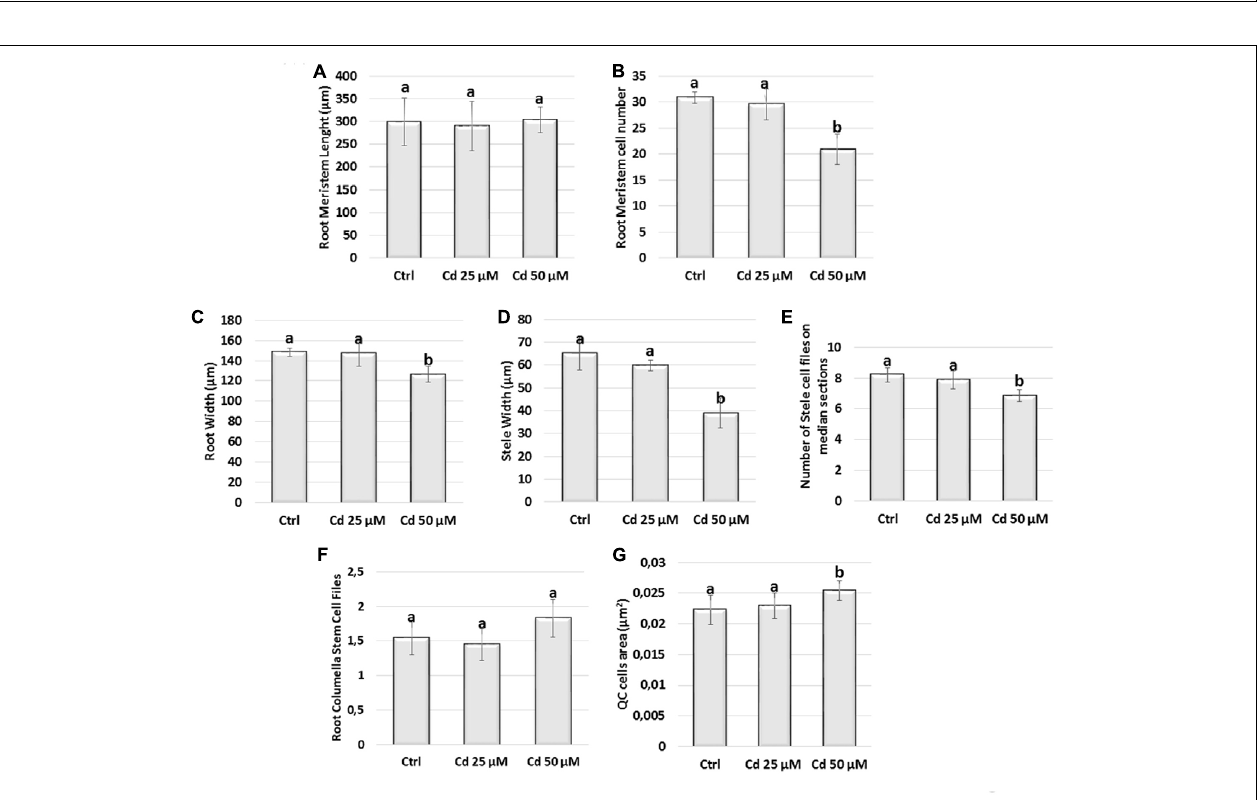
FIGURE 2 | (A) Meristem length ( µ m), (B) meristem cell number, (C) meristem width ( µ m), (D) stele width ( µ m), (E) stele cell files number, (F) calyptrogen layers number, (G) quiescent center cell area ( µ m 2 ), in roots of A. thaliana seedlings germinated on growth medium as control (Ctrl); and on medium added with 25 or 50 µ M Cd for 8 days after germination (DAG). Data present the mean ± standard deviation (SD) of three independent experiments. Statistical analysis was performed by using one-way ANOVA with Tukey post hoc test ( P ≤ 0.05) after Shapiro–Wilk normality test. Means with the same letter are not significantly different at P <